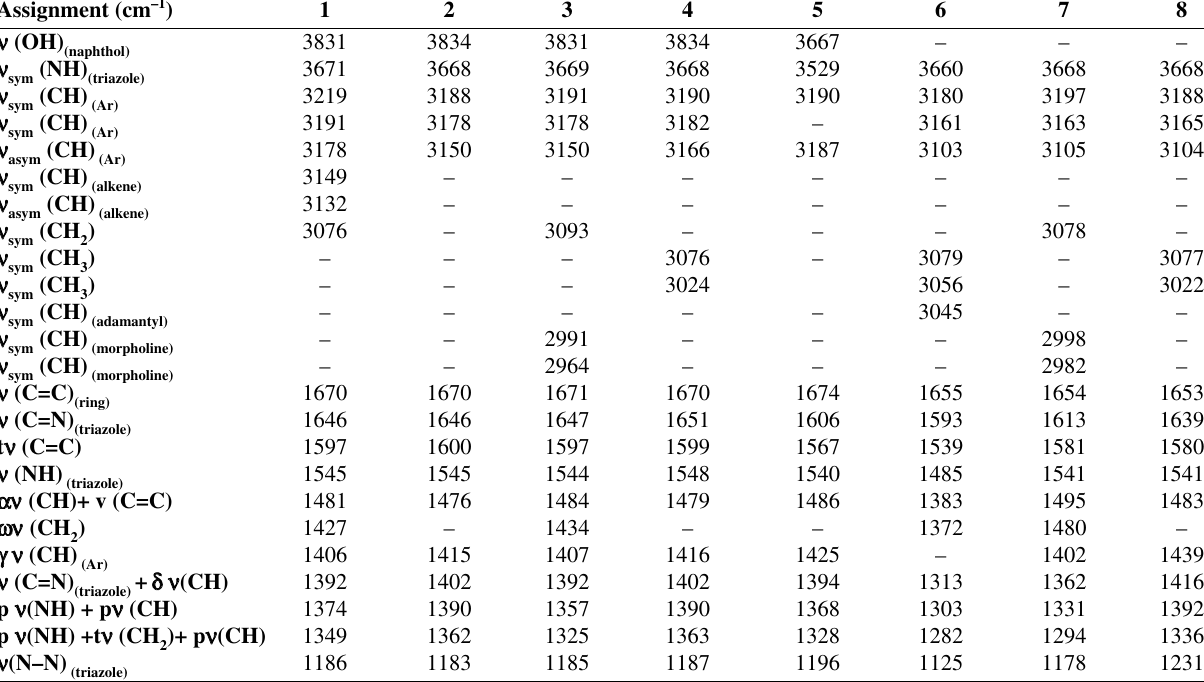
Table 1. Calculated B3LYP/ 6-311G + (d,p) level vibrational frequencies (cm –1 ) of compounds ( (1–8) ) Assignment (cm –1 )